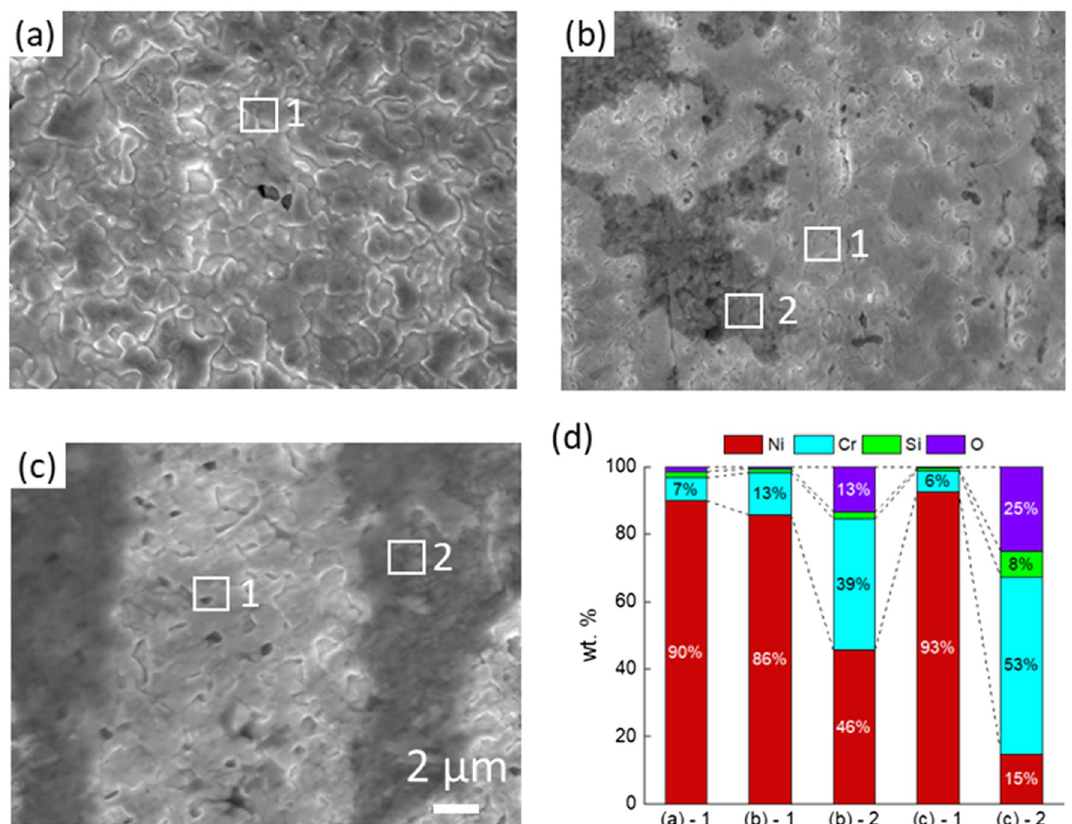
Figure 2. SEM images and elemental analysis of Ni–20Cr alloy corrosion in molten salts under different conditions for 1 h: ( a ) KCl–MgCl 2 in vacuum, ( b ) KCl–NaCl in vacuum, ( c ) KCl–NaCl in air, and ( d ) the elemental analysis by